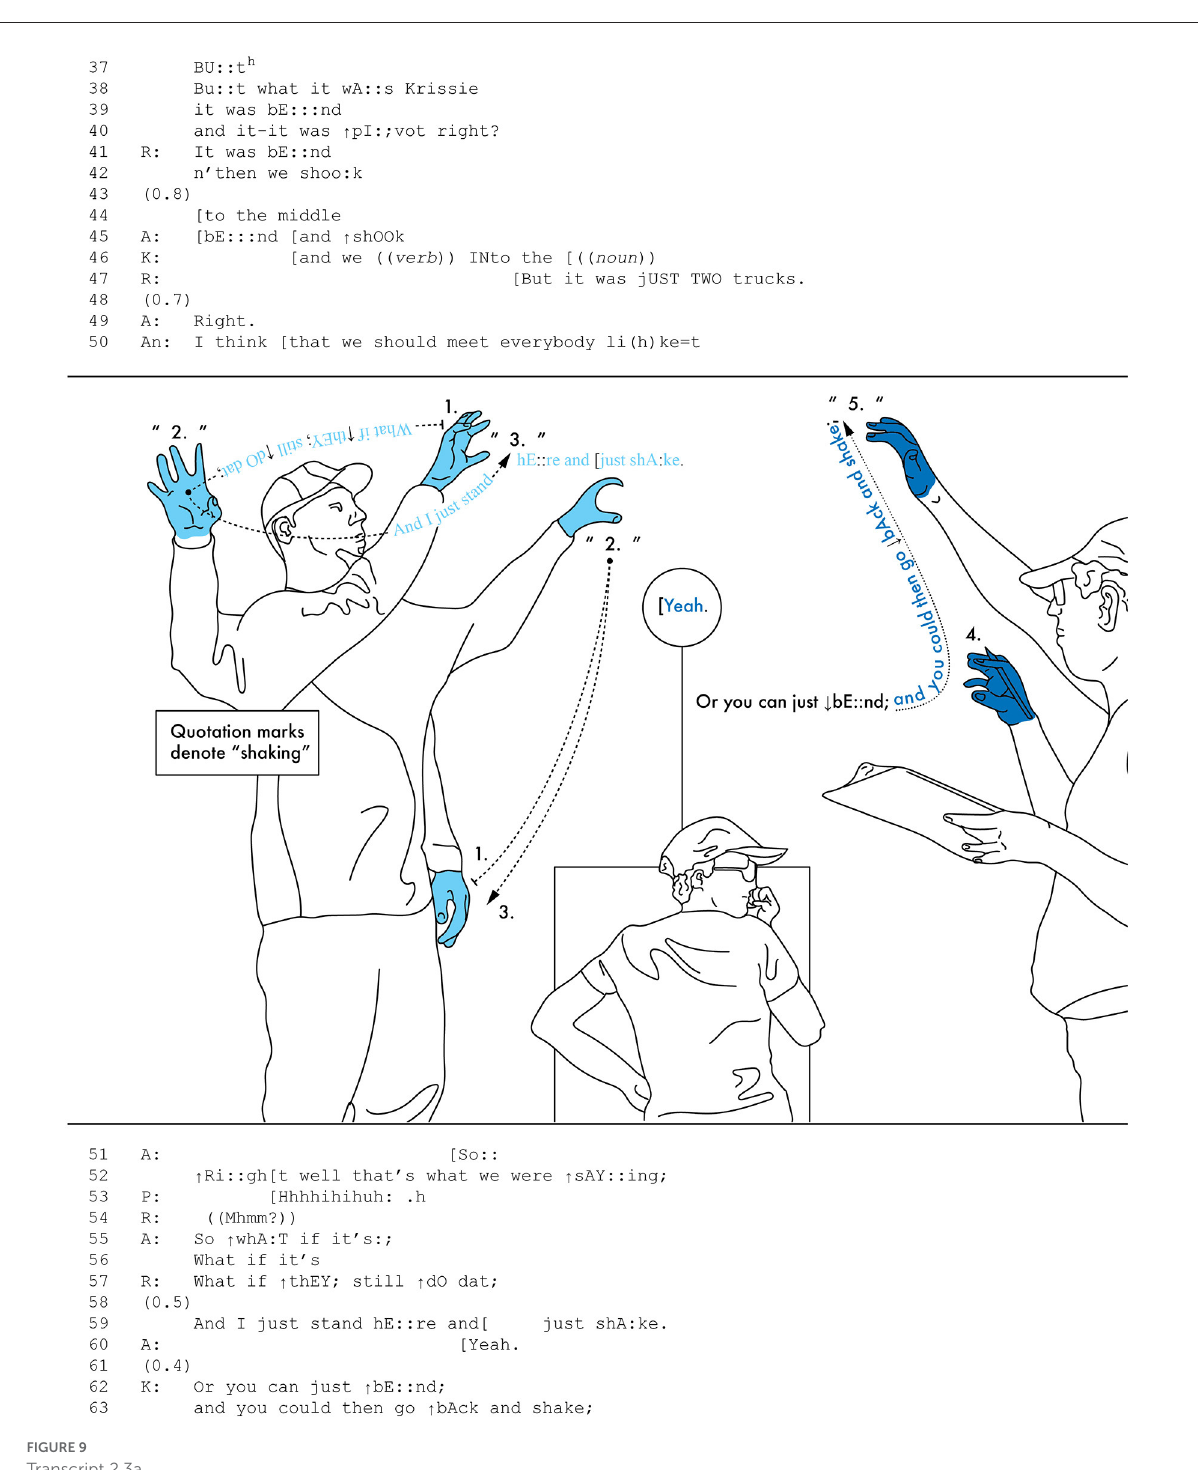
“takes over.” Roy marks (and thus depicts) the action of the two cranes rotating and facing each other instead of verbalizing this part of the dance phrase. Roy is marking out the movements of